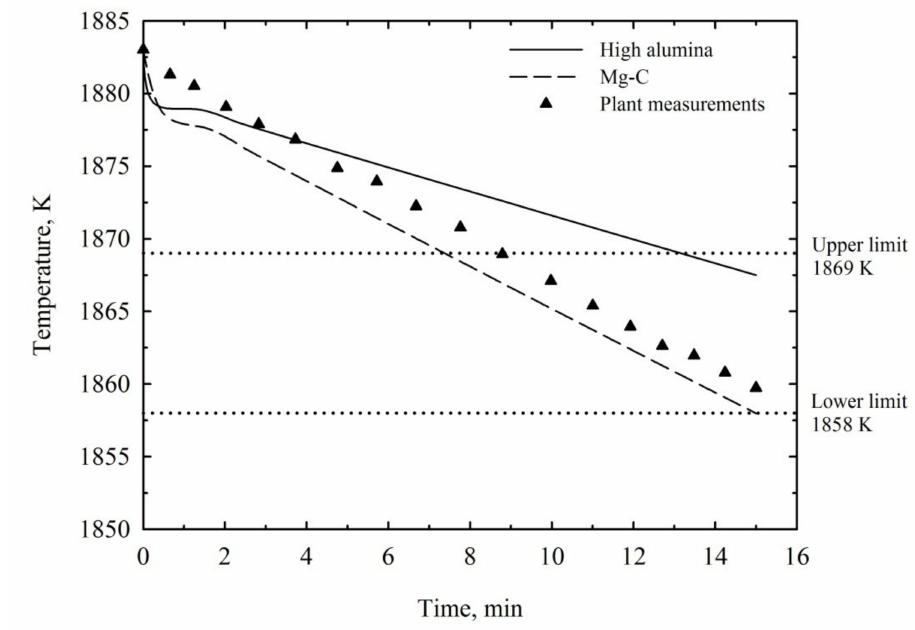
Figure 8. Effect of refractory on steel ladle temperature.